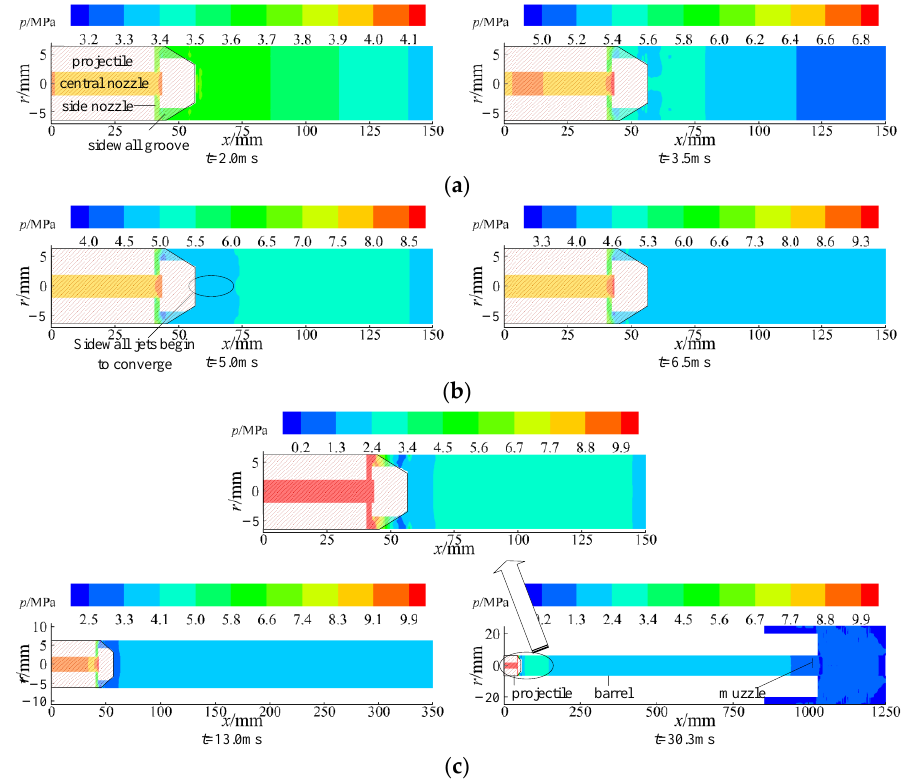
Figure 11. Pressure distribution (projectile C). ( a ) The first stage; ( b ) the second stage; ( c ) the third stage.